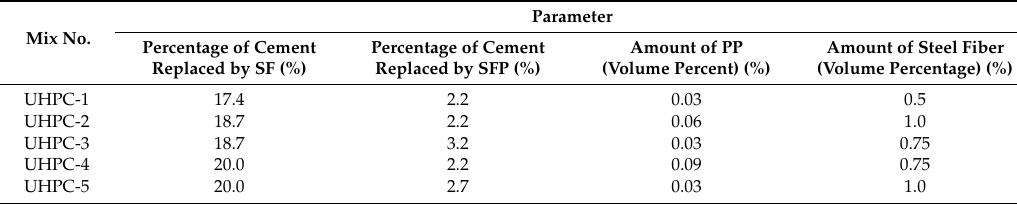
Table 5. UHPC test